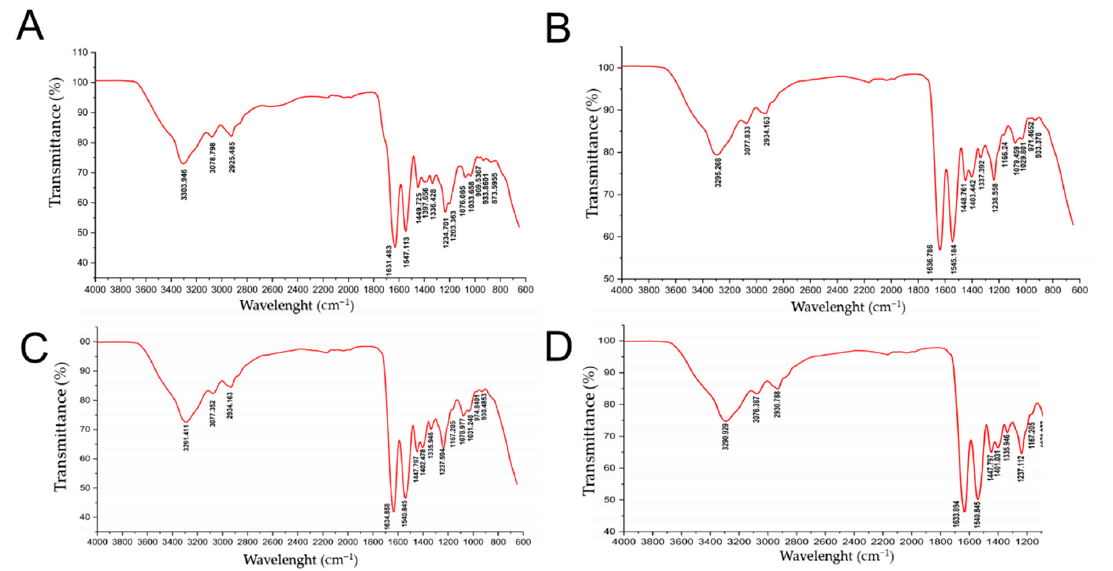
Figure 6. FTIR profile of collagens extracted in 0.5 M acetic acid from tilapia skin. ( A ). Collagen from calf skin (SIGMA); ( B ). Collagen from F1 progeny; ( C ). Red strain collagen; ( D ). Gray strain collagen.